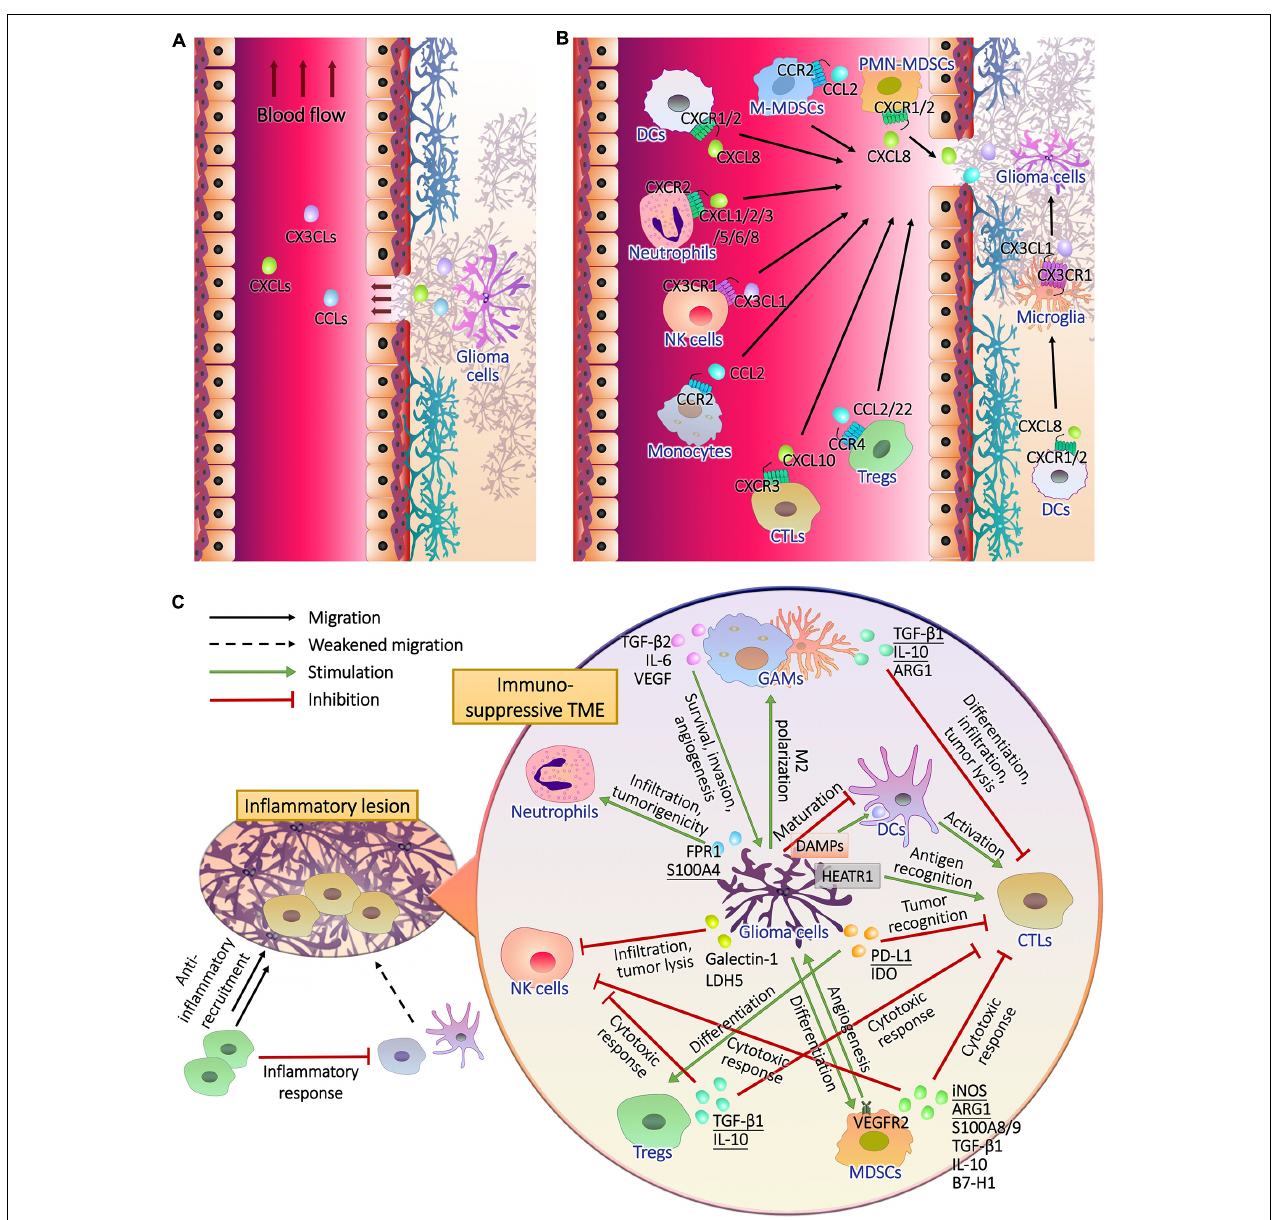
FIGURE 2 | The recruitment of immune cells and the formation of immunosuppressive glioma microenvironment. (A) Glioma cells release chemokines to lesion tissues, part of which entered peripheral blood through the pathological blood brain barrier. (B) After the chemokine receptors of peripheral and intracranial immune cells captured their ligands, they drive the cells to migrate upstream where chemokines are released. (C) During the infiltration of inflammatory T cells, anti-inflammatory cells, mainly regulatory T cells (Tregs), are recruited to inhibit the antigen presentation of dendritic cells (DCs) and T cell activation, resulting in impaired immune response. In addition to the activation of anti-inflammatory mechanisms, glioma cells perform complex intercellular interactions with immune cells in tumor microenvironment. Cytotoxic T lymphocytes (CTLs) should recognize tumor antigen HEAT repeat-containing protein 1 (HEATR1) and kill glioma cells with natural killer (NK) cells, and CTLs were activated by mature DCs during the presentation of damage associated molecular patterns (DAMPs) released by glioma cells. Glioma cells inhibited the maturation of DCs. Furthermore, glioma cells secreted cytokines to induce the generation and recruitment of tumorigenic